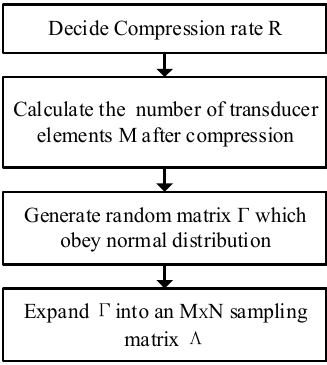
Figure 2. The process of designing a sampling matrix.